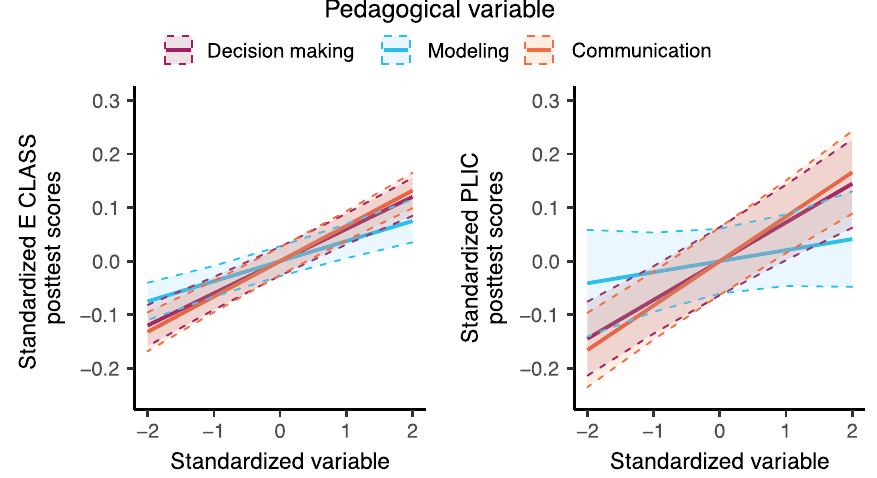
FIG. 3. Expected post-test scores (i.e., marginal effects) on the E-CLASS and PLIC as a function of time spent on decision-making, modeling, and communication activities. Post-test scores are higher in labs with more activities related to decision making and communication, with a small effect from modeling activities. The shading represents the 68% confidence intervals on the